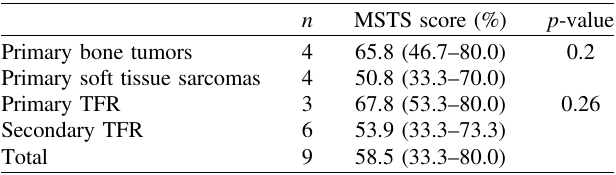
Table 2. Functional outcomes.